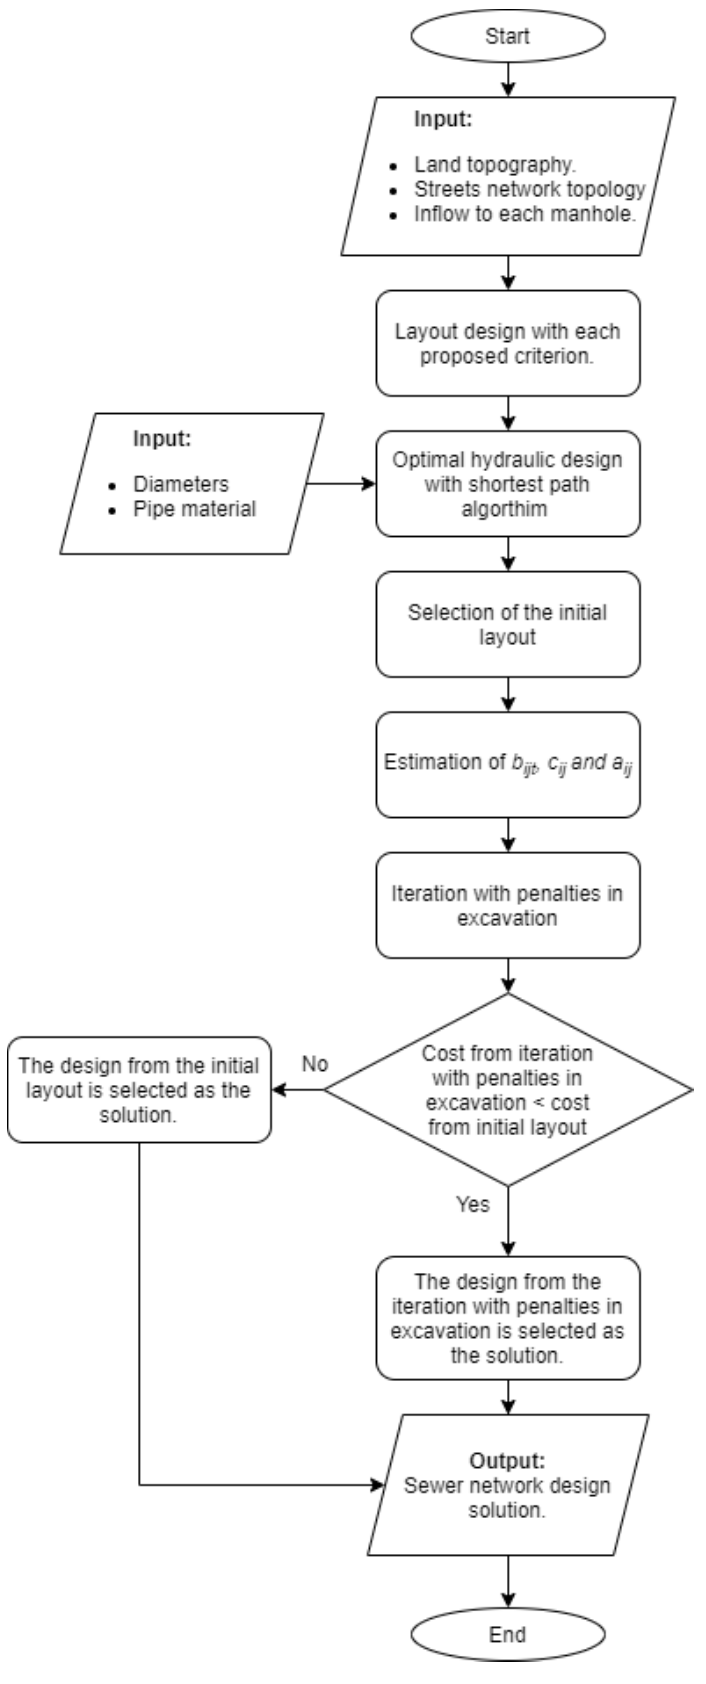
Figure 5. Methodology flow chart.